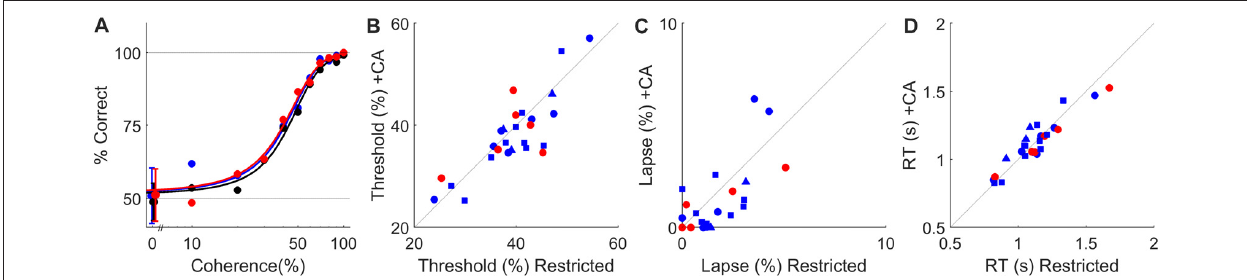
FIGURE 4 | Ad lib CA water does not impact psychophysical performance. (A) Psychometric curves for a typical rat tested under water restriction (black) or with ad lib water containing 2% CA (blue) or 4% CA (red) in the live-in protocol. Dashed lines indicate chance and perfect performance. Psychophysical thresholds (defined as coherence at which accuracy is 75%) were 43%, 41% and 40% coherence for restricted, 2% CA and 4% CA respectively. Lapse (error rate at 100% coherence) was ≤ 1% in all three conditions. In panels (B–D) , data from 24-h task access are plotted as circles, with color indicating CA concentration (blue for 2%, red for 4%). Data from 2-h task access are plotted as squares (no supplement) or triangles (supplemental water in restricted condition), as in Figure 3 . (B) Psychophysical threshold (% coherence at 75% correct) with water restriction vs. with ad lib CA water in all N = 26 experiments from Figures 2 , 3 . (C) Psychophysical lapse with water restriction vs. with ad lib CA water. Data shown on this scale are for the N = 23 experiments with lapse < 10%. In three other experiments lapse was >10% on both conditions (off scale); these were also not affected significantly by ad lib CA. (D) Mean reaction time with water restriction vs. with ad lib CA water.